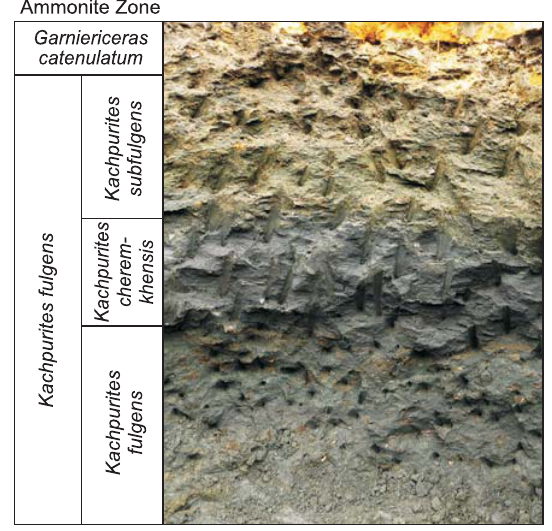
Fig. 3. Upper Volgian strata in Eganovo locality. Three subzones of Kachpurites fulgens Zone. The thickness of all layers is about 1.4 m. The traces on the surface of the layer have been left by the excavation knife.